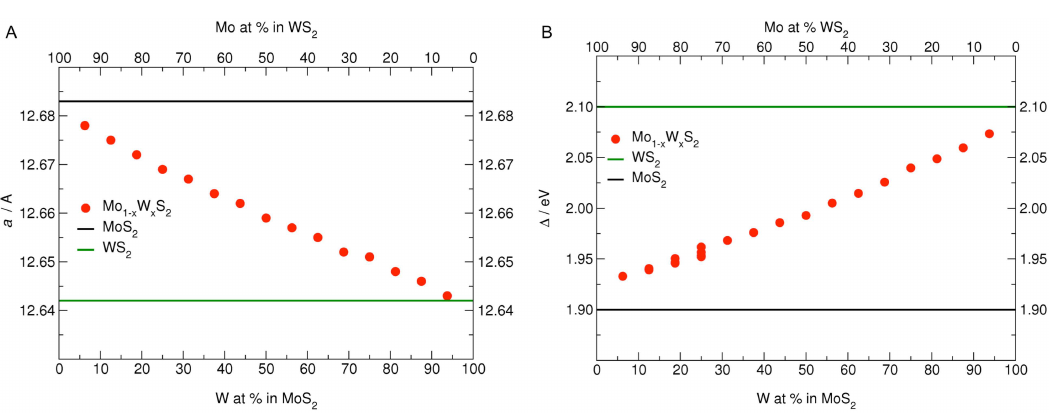
Figure 3. ( A ) The change of lattice parameter a and ( B ) the band gap ∆ in Mo 1 ´ x W x S 2 systems ( x “ 0 ´ 1). The values of MoS 2 and WS 2 monolayers are shown with black and green horizontal lines,